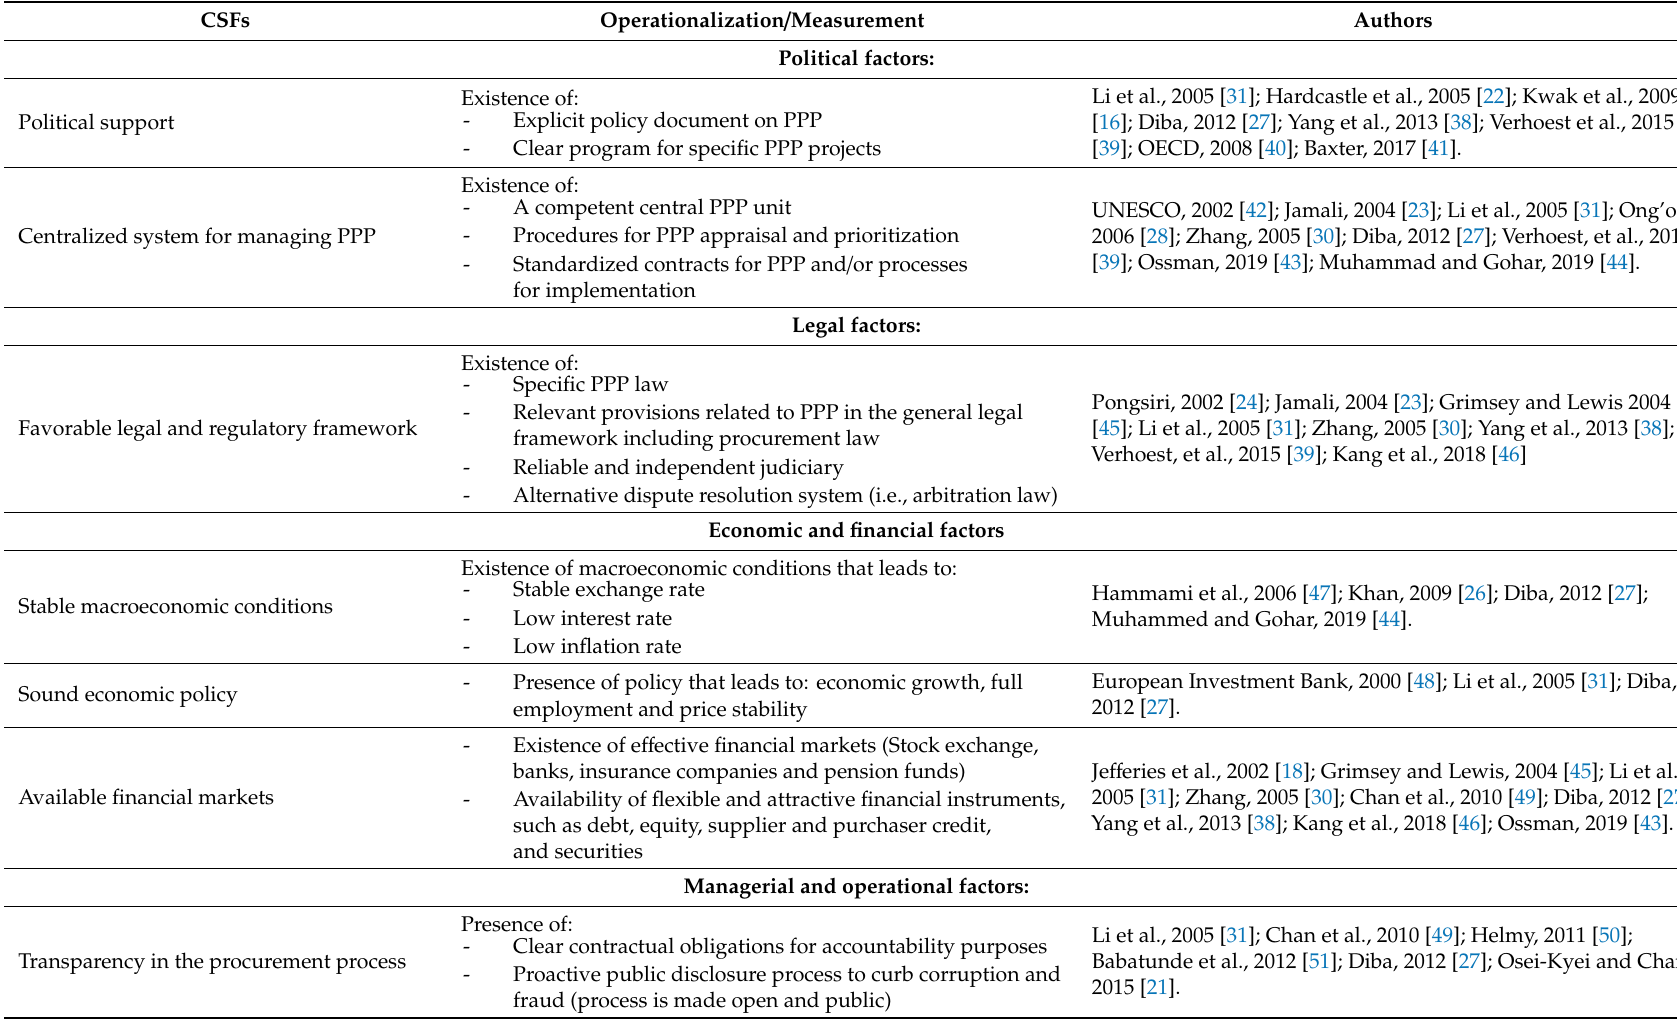
Table 3. Operationalization of